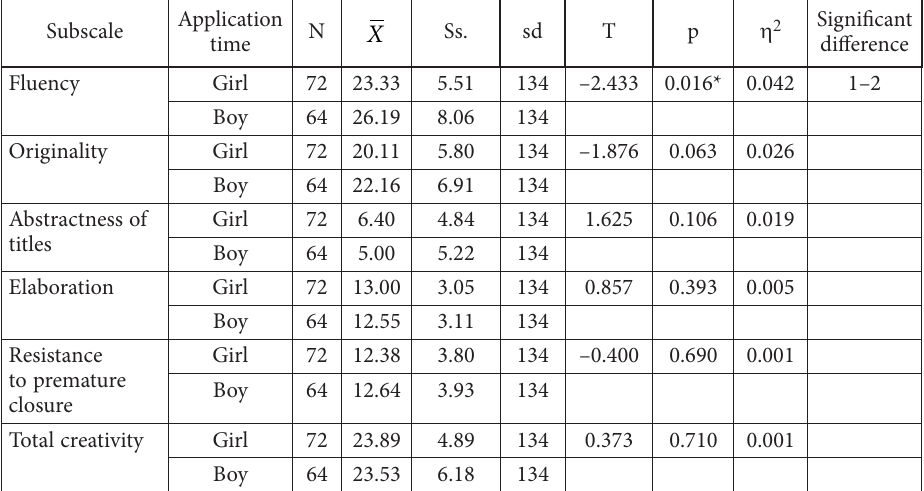
Table 6. T-test results of the creativity scores of the adolescents in the 12th grade based on gender (source: created by author)